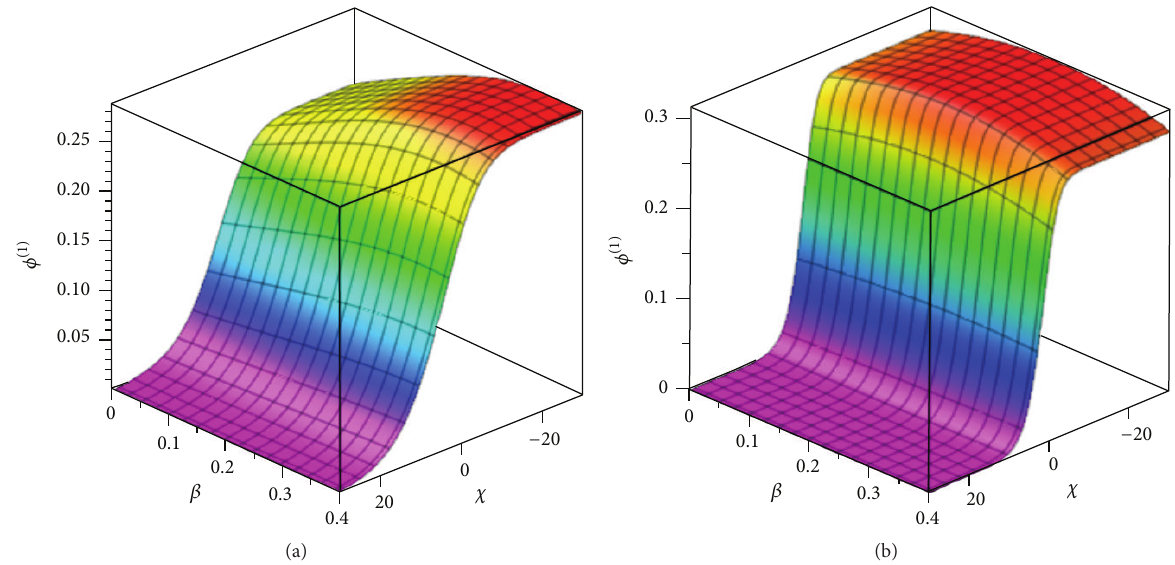
Figure 1: Weakly relativistic ( 𝛽 = 𝑢 𝑖0 /𝑐 ) effects on the spatial potential ( 𝜙 (1) ) profiles of IA shock waves in plasmas, taking 𝛼 = 0.1 , 𝜎 = 1 , = 0.96 for the thermality parameter (a) 𝑞 = 0.6 and (b) 𝑞 = 2 . 𝛿 = 0.01 , and 𝜇 0